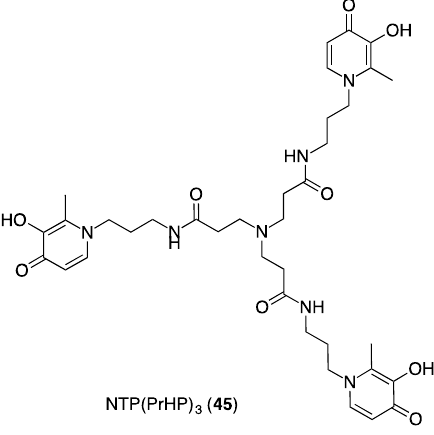
Figure 14. Structure of NTP(PrHP) 3 .